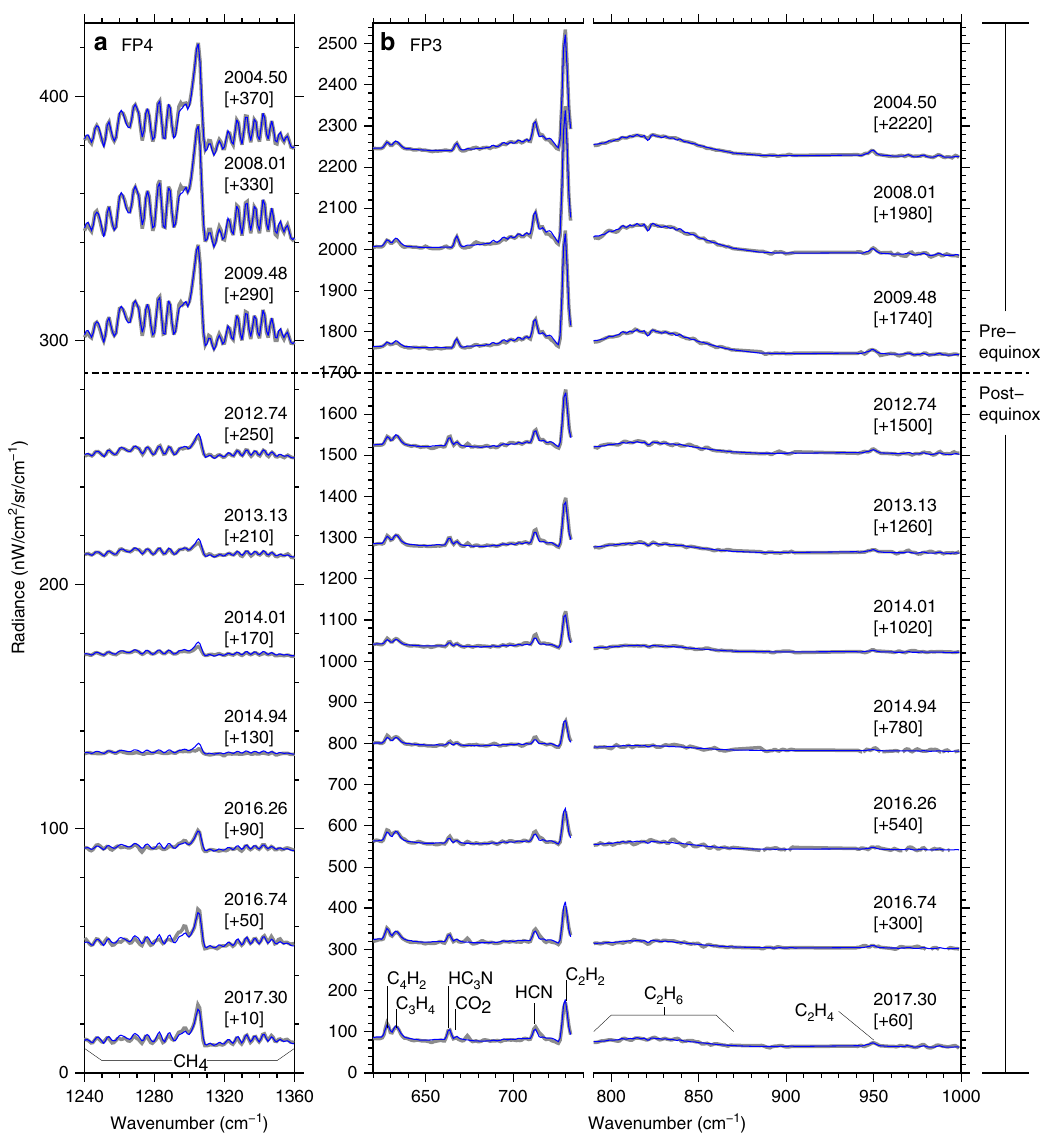
Fig. 5 Evolution of Cassini CIRS nadir spectra of the south polar vortex. a FP4 spectra of the ν 4 methane band, sensitive to stratospheric/mesospheric temperature. Pre equinox spectra show high emission and have a corresponding high temperature, whereas post-equinox spectra show minimal ν 4 emission, indicating very cold stratospheric/mesospheric temperatures. From 2016 ν 4 emission begins to increase indicating a return to a warm polar state. b FP3 spectra of trace gas emission peaks (labelled). Moderate trace gas emission enhancement is evident in the post-equinox spectra. For example, the HC 3 N peak is more prominent from late 2012 onwards, despite the cold temperature prevalent at that time. All data were measured at 80°S. Blue lines show fi ts and grey lines with 1- σ error envelopes show measured spectra. All data are fi tted to within measurement uncertainty. Spectra are offset in radiance for clarity by the amount shown in square